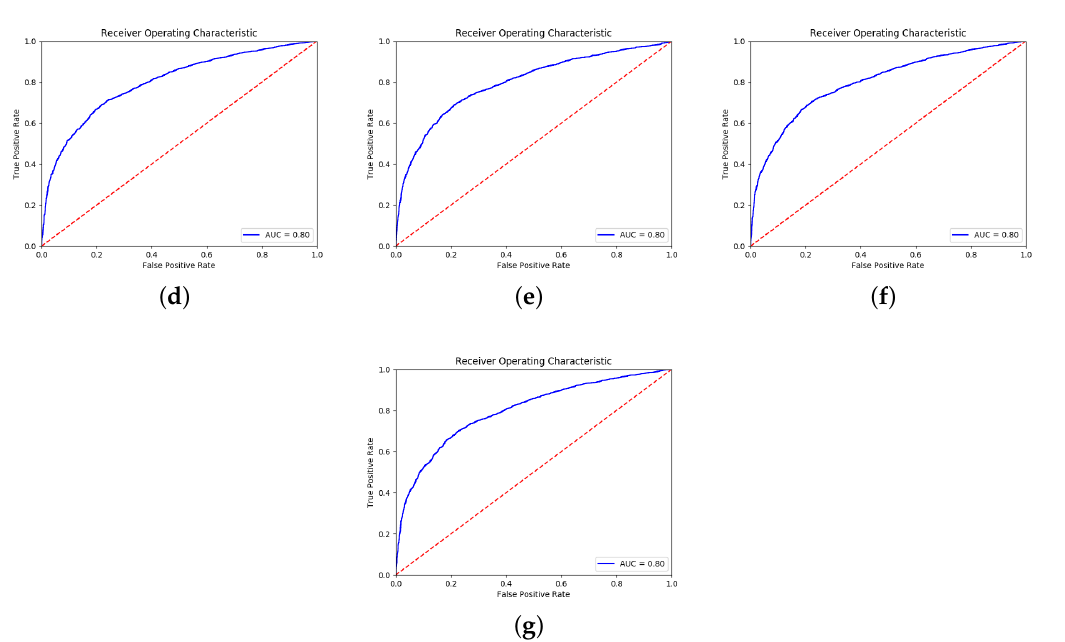
Figure 3. ROC curves obtained using each measures to predict the accuracy on the CIFAR validation set. Measures e , s , d img , g , d feat , mix 1 and mix 2 are, respectively, plotted in ( a – g